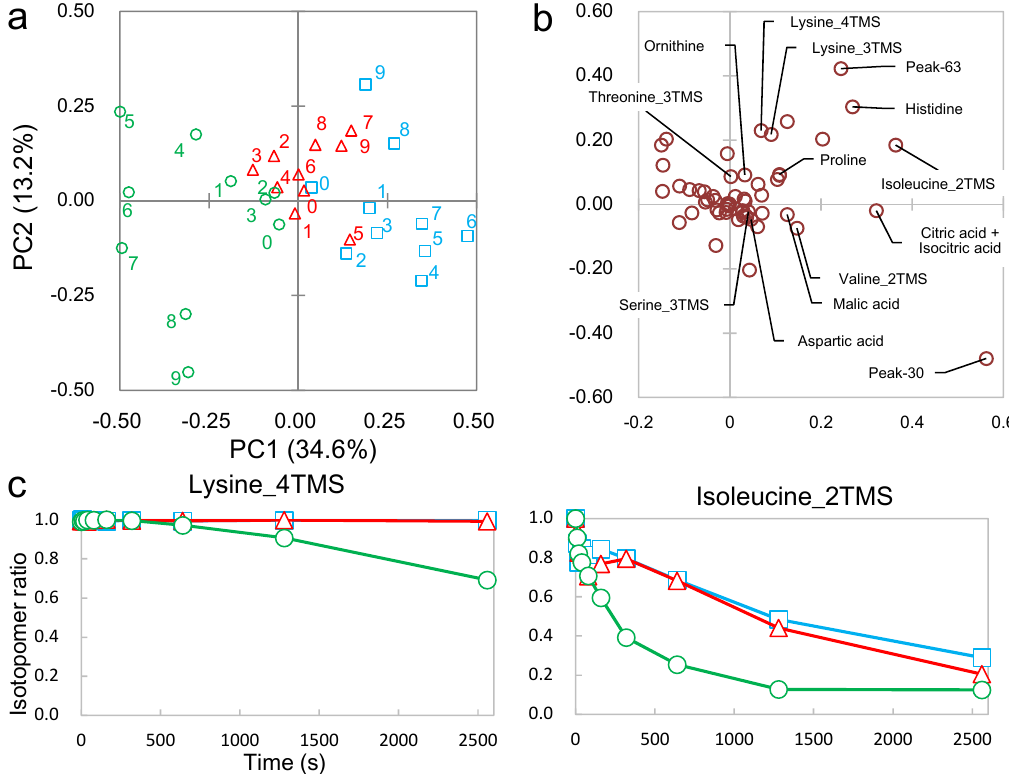
Figure 3. Principle component analysis (PCA) of metabolic turnover differences. ( a ) PCA score plot of each sampling time of three respective sample types: BY4742 under SD medium with amino acid supplement (open square), X2180 under SD medium with amino acid supplement (open triangle), and X2180 under SD medium without amino acid supplement (open circle). Numbers 0–9 indicate sampling times: 0, 10, 20, 40, 80, 160, 320, 640, 1280, and 2560 s, respectively. The horizontal axis indicates principal component (PC) 1, and the vertical axis indicates PC 2. The values in parentheses are the percent variances of each PC; ( b ) loading plot of peaks used in PCA. The labeled peaks represent metabolites that are significantly correlated with the PCs (Table S1). Axes are labeled as in ( a ); ( c ) Time courses of isotopomer ratios of 12 C-monoisotopic lysine and isoleucine peaks. The horizontal axis indicates the sampling time, and the vertical axis indicates the isotopomer ratios. Sample type symbols are the same as for ( a